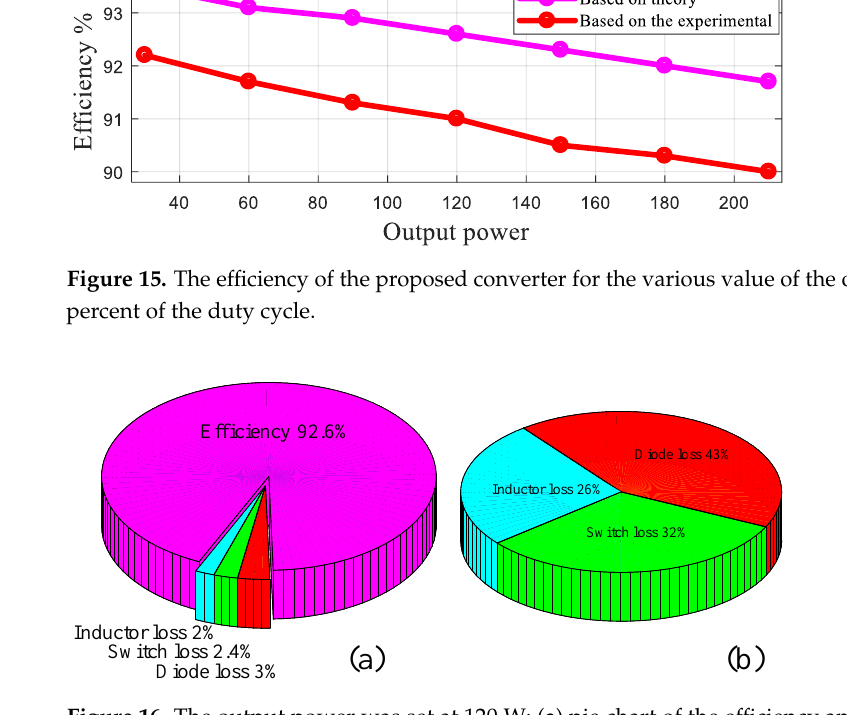
Figure 16. The output power was set at 120 W: ( a ) pie chart of the efficiency and power losses, and ( b ) the percentage of the power